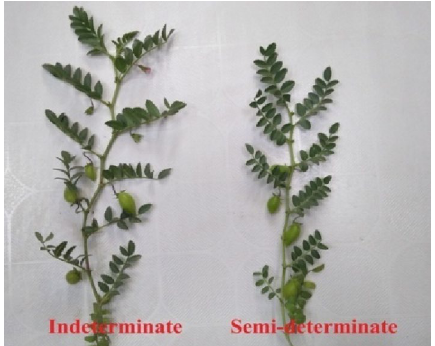
Figure 1. Stem growth habit of BG362 (IDT) and BG3078-1(SDT) at early